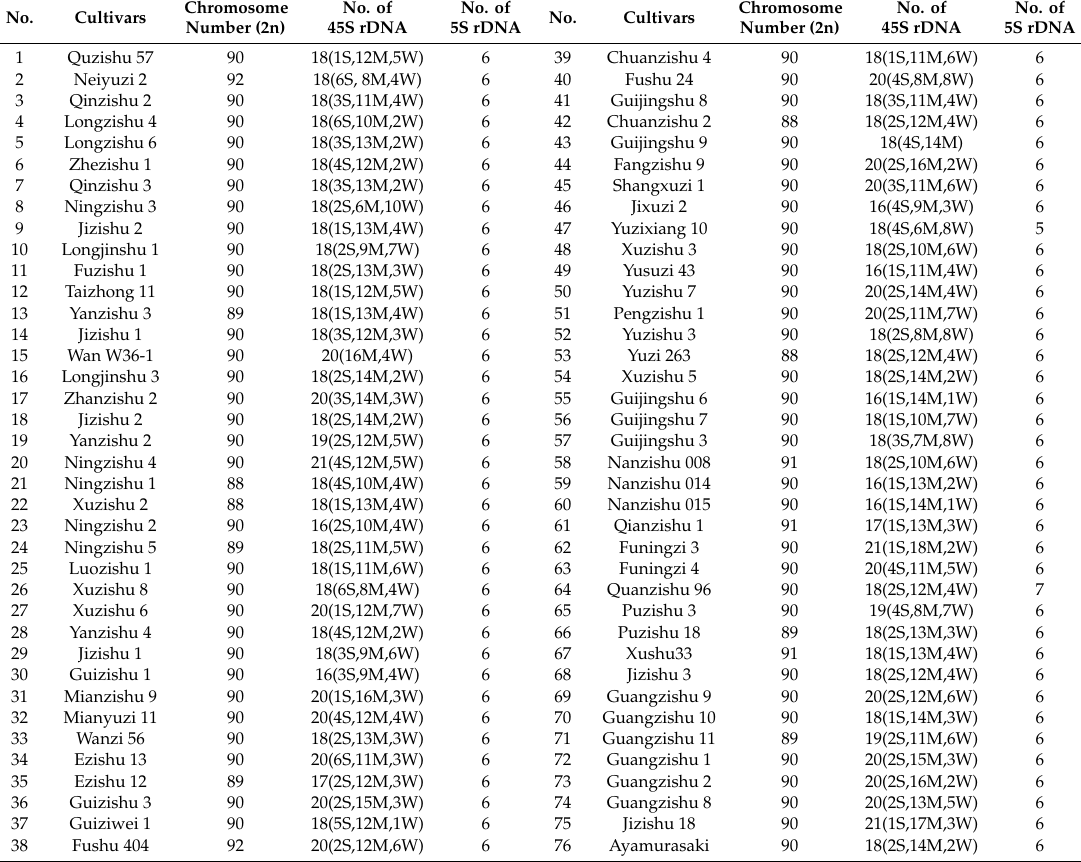
Table 1. Summary of rDNA results of 76 purple-fleshed sweet potato